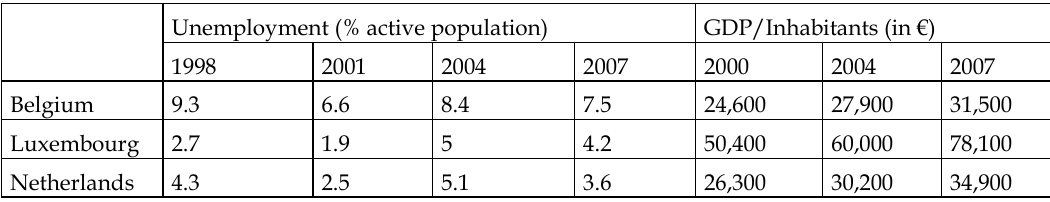
Table 3. Unemployment and GDP per capita in Benelux Unemployment (% active population) GDP/Inhabitants (in